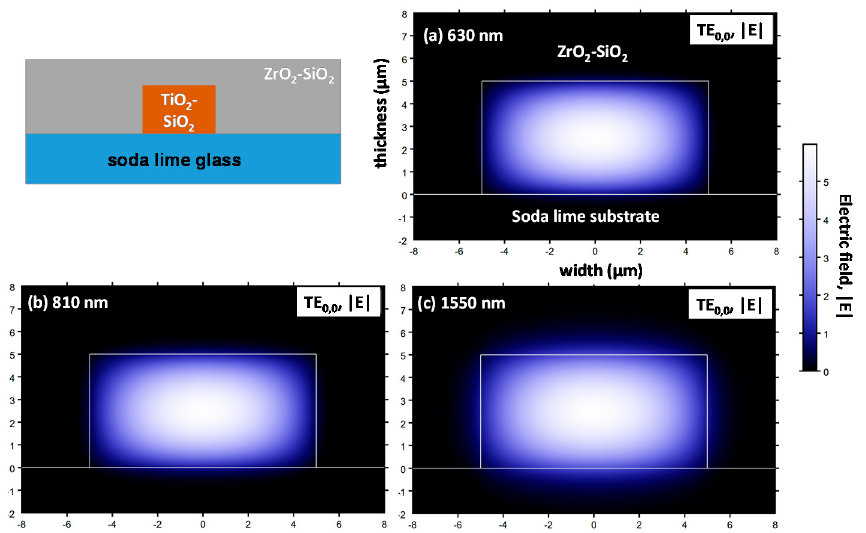
Figure 13. Simulated TE 00 mode of a TiO 2 –SiO 2 waveguide deposited on soda-lime glass and surrounded by the ZrO 2 –SiO 2 cladding and operating at ( a ) 630 nm, ( b ) 810 nm and ( c ) 1550 nm. The thicknesses and widths are 5 µ m and 10 µ m, respectively. Table 4. Confinement factor Г for the two architectures presented: the guide, deposited on a soda-lime glass substrate, is surrounded by the air ( Г 1 ) or by the ZrO 2 –SiO 2 cladding layer ( Г 2 ). Wavelength (nm) Г 1 (Surrounded by Air) Г 2 (Surrounded by Cladding)